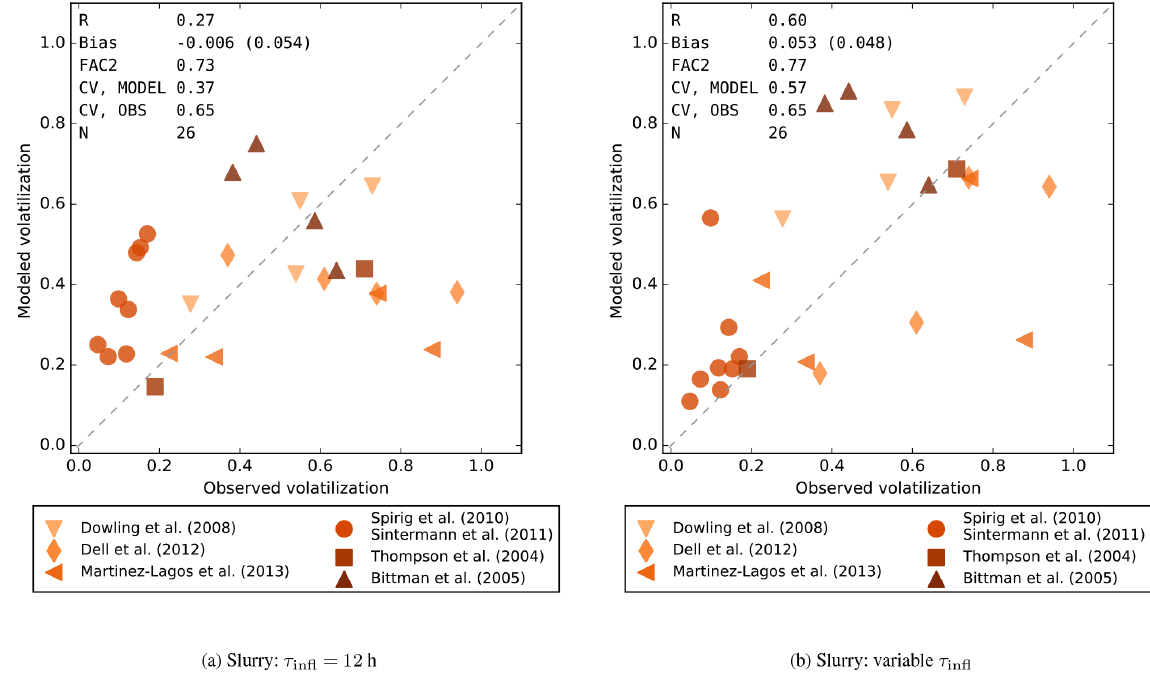
Figure 5. Modeled volatilization losses compared with field observations for slurry. (a) Results with 12h infiltration time and no adjustment for application rate. (b) Results using reported application rates and infiltration times adjusted based on dry matter content. Abbreviations used are as in Fig. 4.